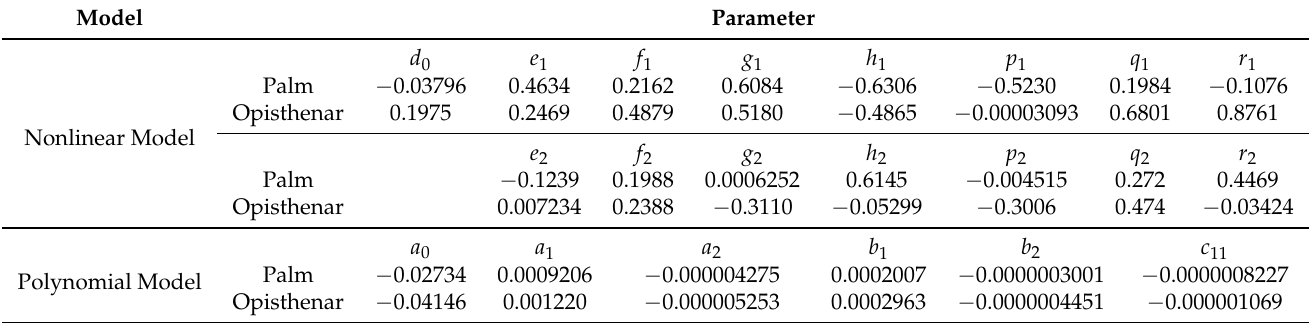
Table 4. The parameters of the two models.